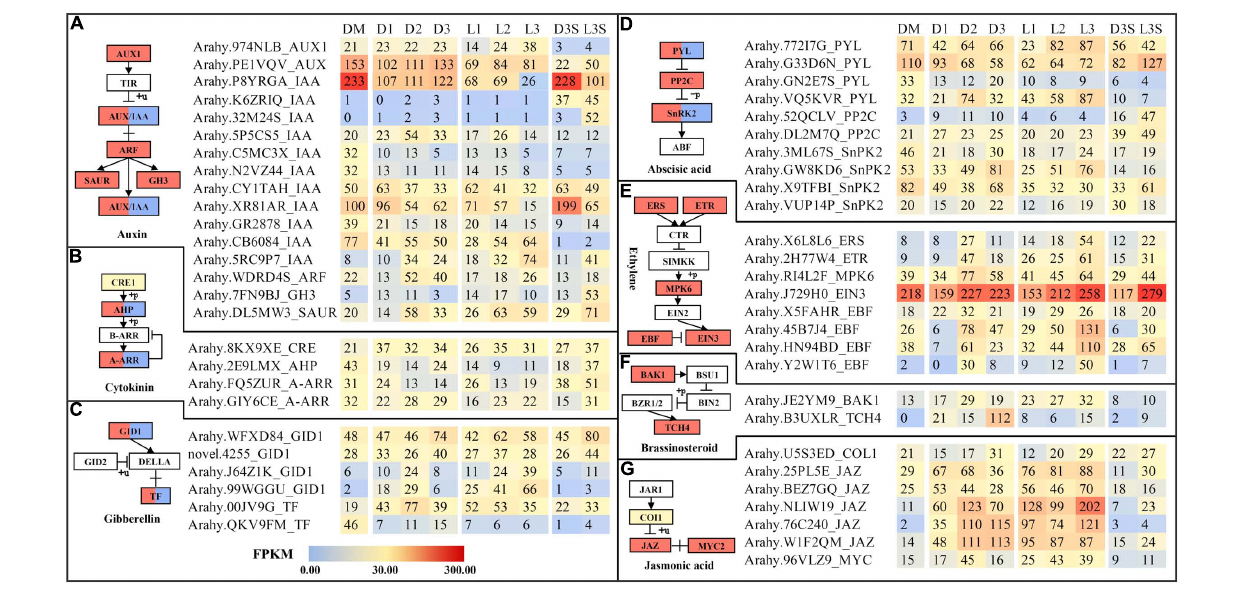
Frontiers in Plant Science |